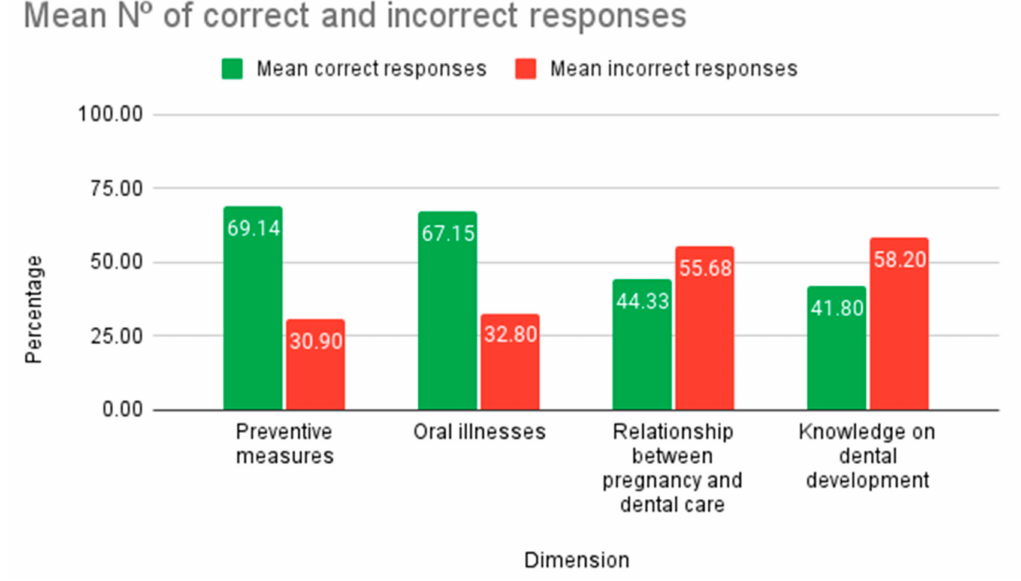
Figure 1. Bar chart of percentages of correct and incorrect answers by